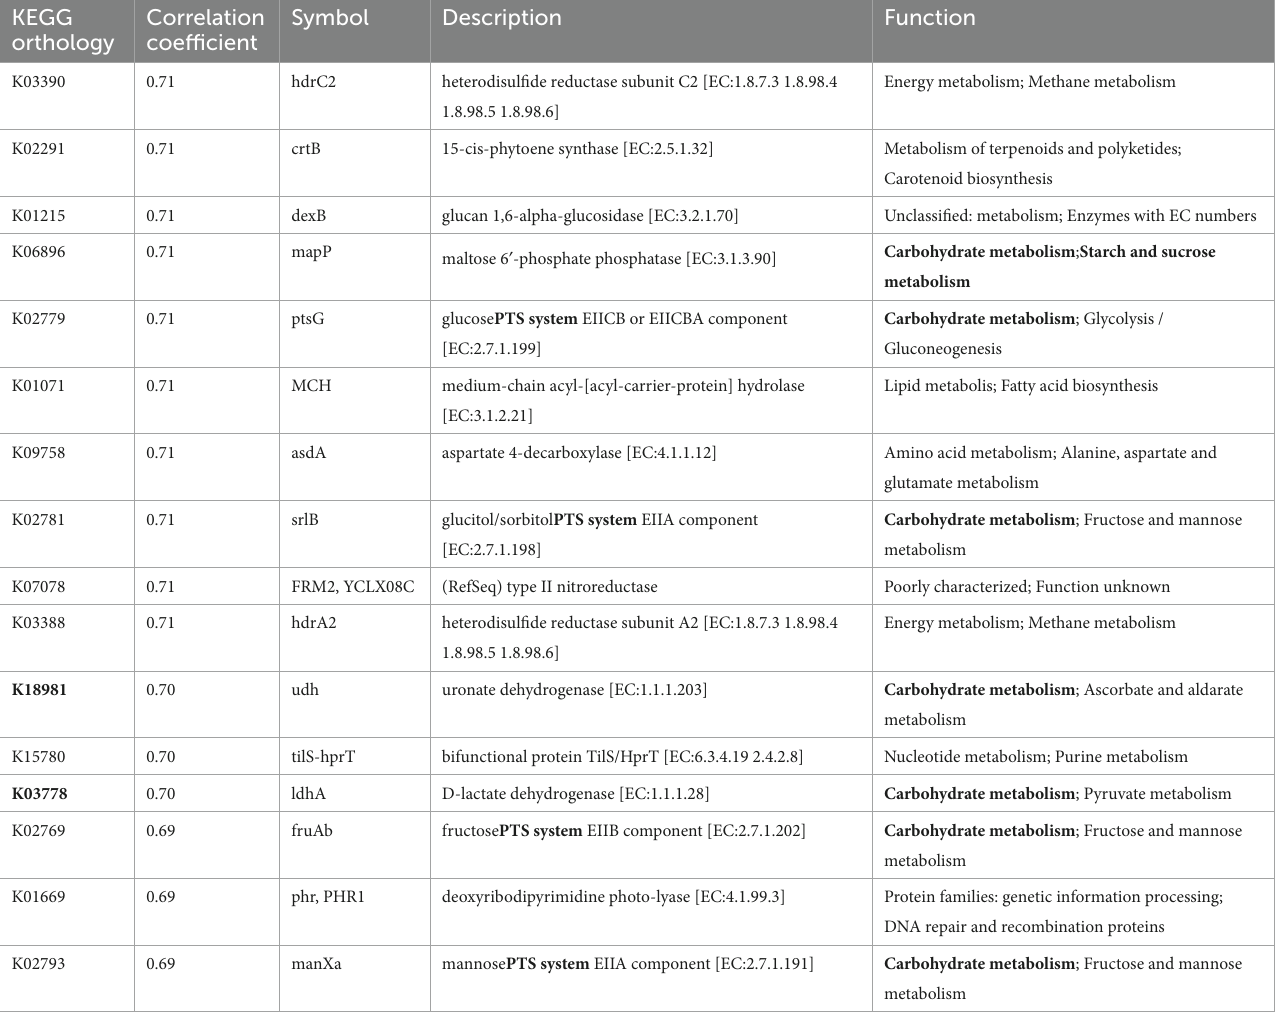
KEGG orthology items of 5,458 described in “pred metagenome unstrat” file created with PICRUSt2. Although the functional category differed from the results of the BURRITO analysis, the functions described the “phosphotransferase system (PTS),” “starch and sucrose metabolisms,” “Prokaryotic defense system,” and “nicotinate and nicotinamide metabolism” were found in the list. Among the KEGG orthology items, seven NAD(P)-dependent oxidoreductases were selected and the related taxa in each orthology and ratio “CountContributedByOTU” at the initiation of indigo reduction in batches 3 [from days 2 to 3 (D3/D2)] and 4 was [from days 3 to 4 (D4/D3)] were estimated using the “pred metagenome contrib.legacy” produced by PICRUSt2 analysis (Table 2).